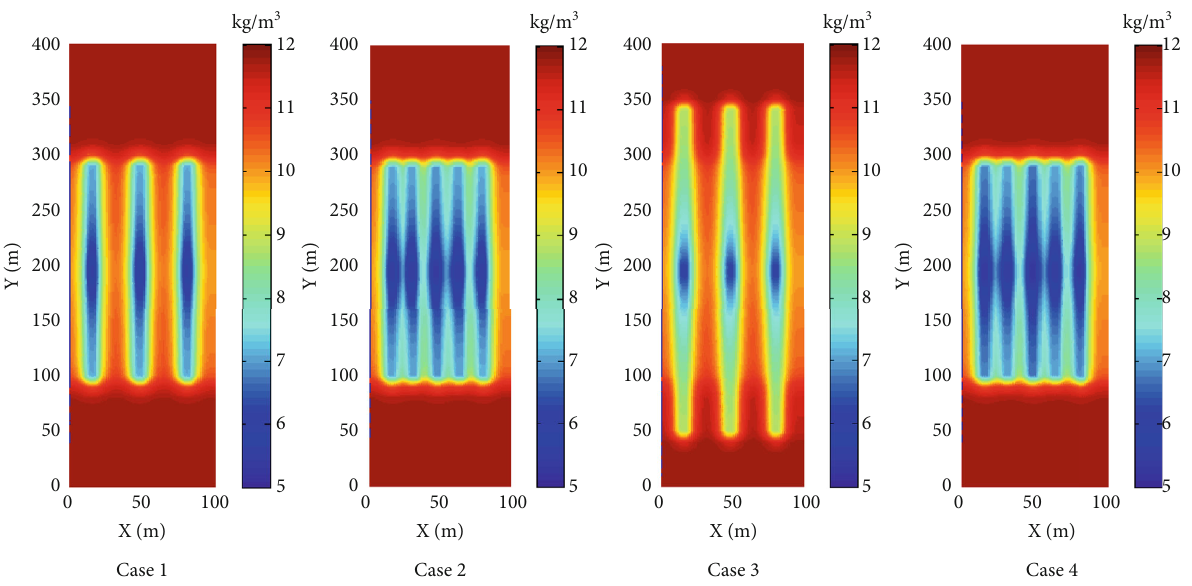
Figure 12: Distribution of reservoir gas content after 10 years corresponding to di ff erent refracturing